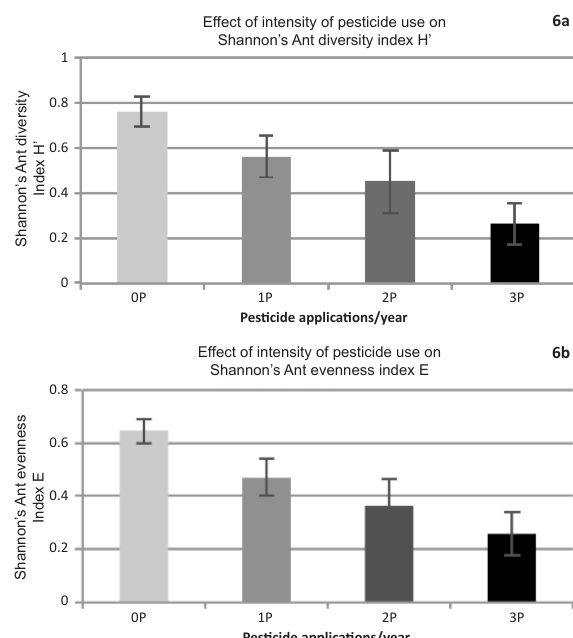
Figure 6. Bar plot shows the effect of increase in chemical pesticides on ant species diversity (Fig. 6a) and evenness (Fig. 6b) indices with their 95% confidence intervals